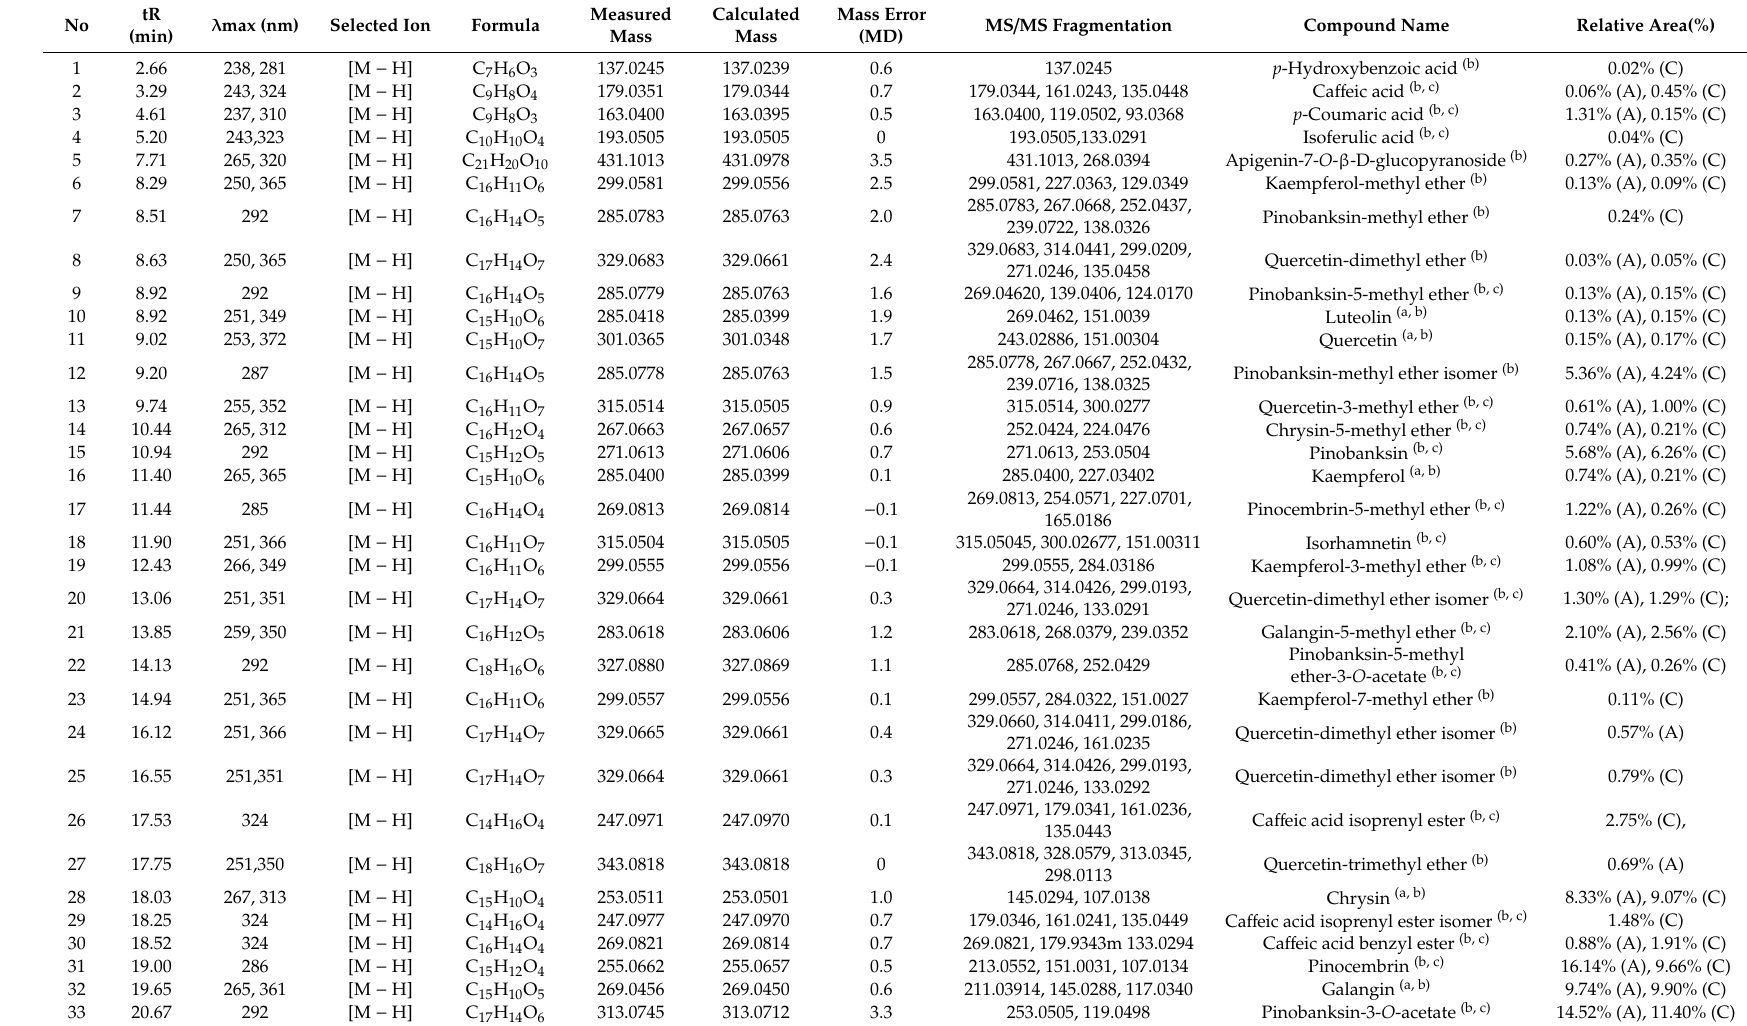
Table 2. Main components of EEP-A and